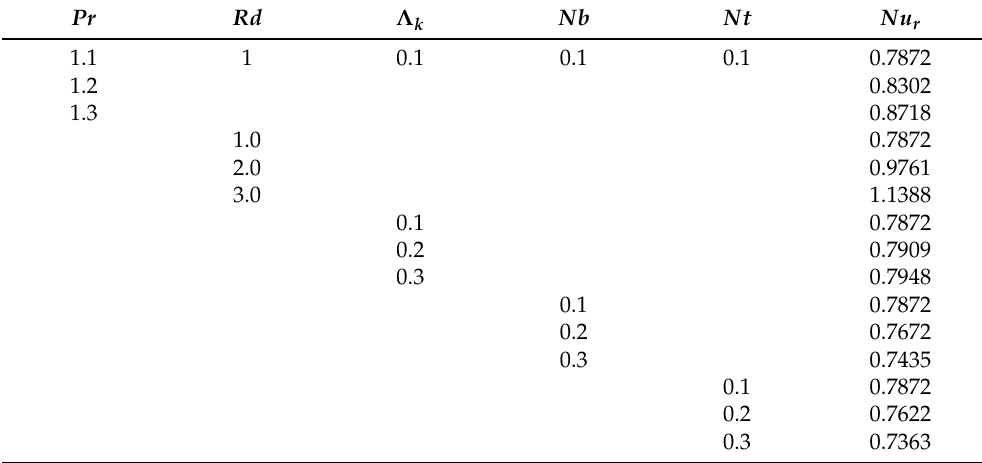
(cid:113) − 1 n + 1 ( 1 + 2 x Nu x = − 2